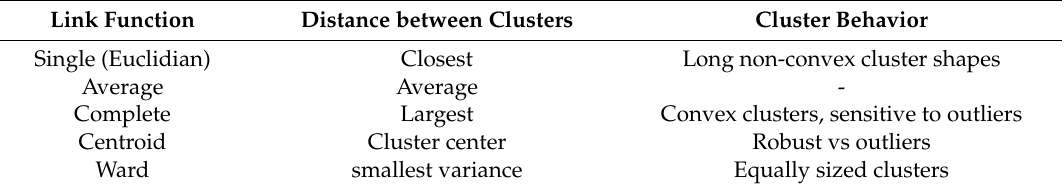
Table 7. Overview of the most prevalent distance measure encountered in the 34 papers, and their